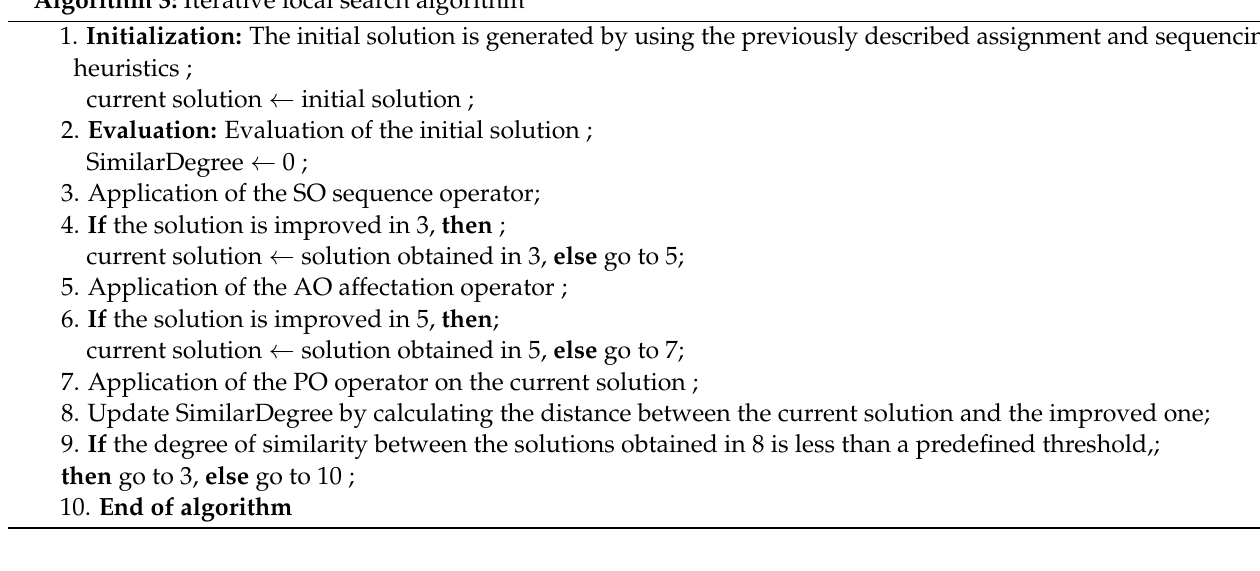
Table 3. Common and different elements between the two iterated local search